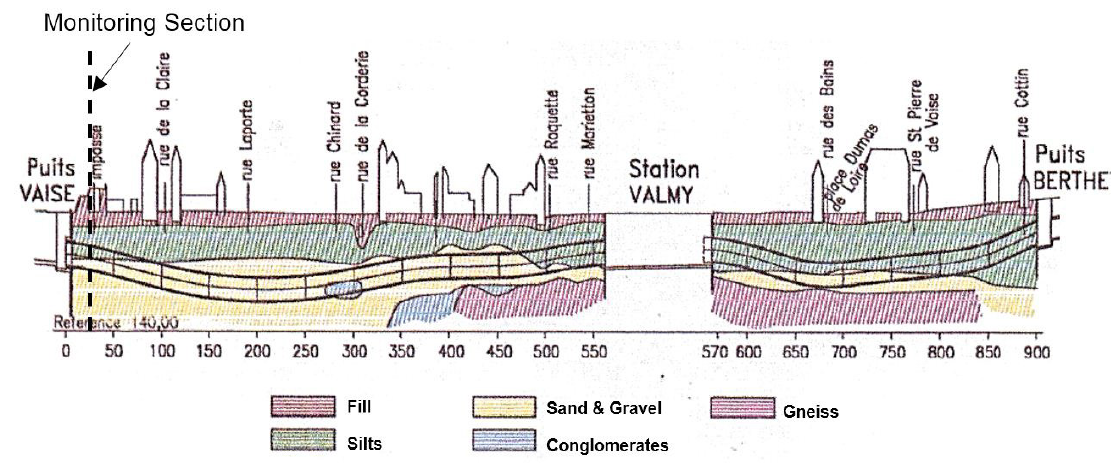
Figure 2: Geological profile.